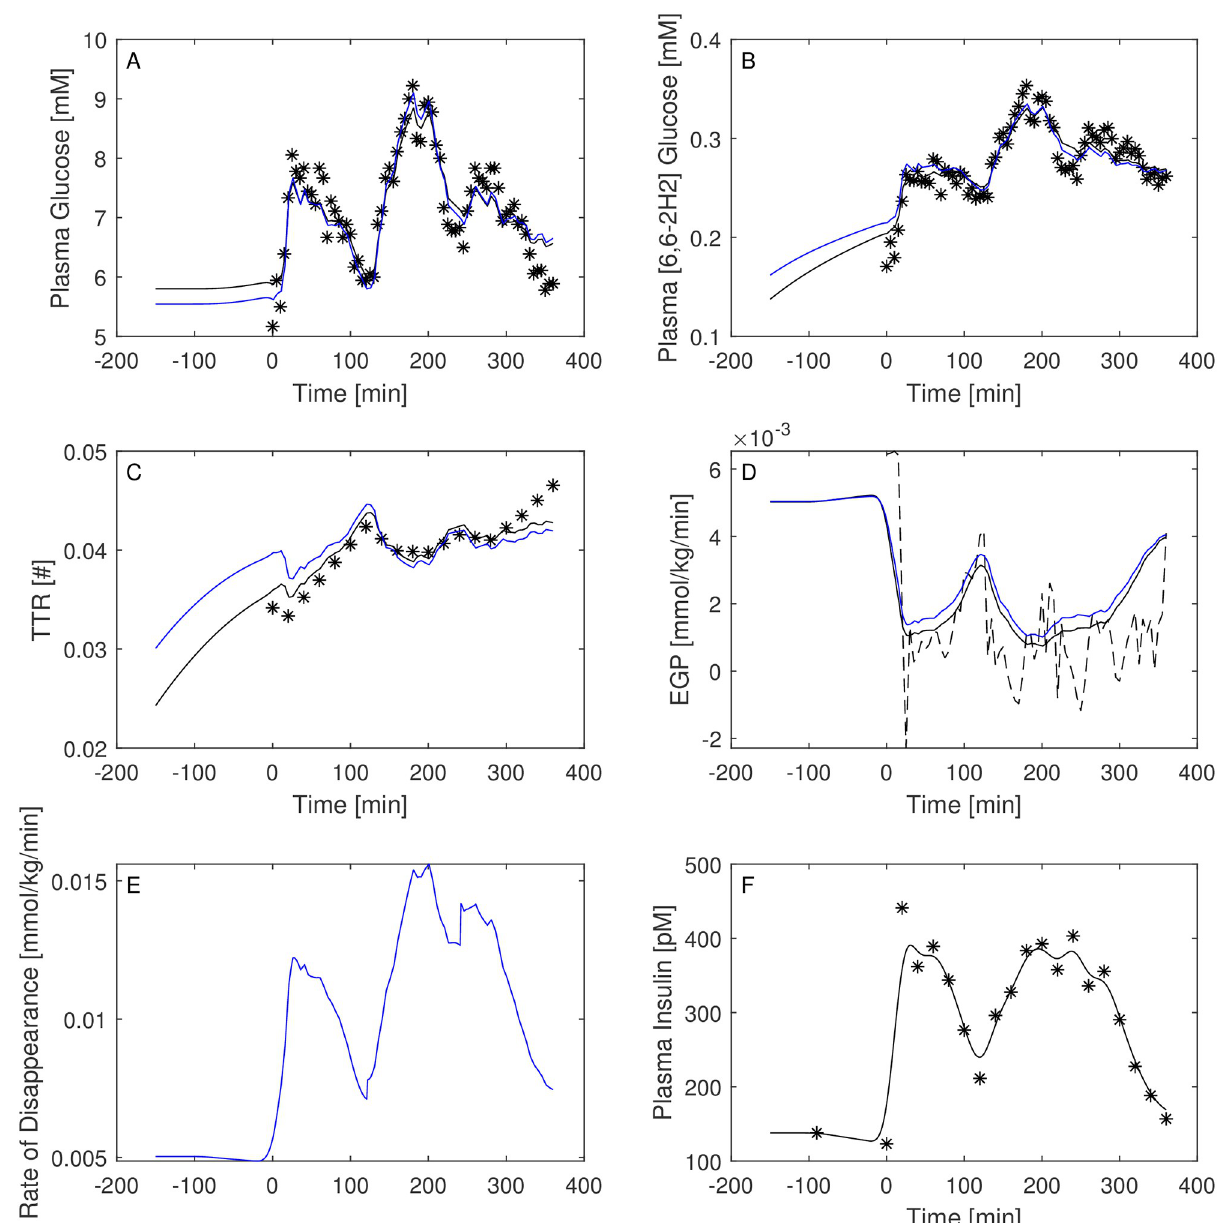
Fig 8. Predictions for Subject 6. Observed (asterisks) and predicted (line) variables over time (IGT subject). EGP: Endogenous Glucose Production; TTR: Tracer to Tracee ratio. Plasma glucose concentration (Panel A); Plasma [6, 6-2H2]glucose (Panel B); TTR (Panel C); EGP (Panel D), dashed line is the predicted EGP with the Steele model; Rate of disappearance (panel E); Plasma Insulin concentrations (Panel F). All the observed points refer to data measured on day 2. Plasma glucose concentrations (panel A) are derived from the glucose intra-venous infusion to match plasma glucose observations from the OGTTs of day 1. Black lines in panels A, B, C, D and E are model predictions from WLS estimation procedure; blue lines derive from the estimation approach which uses autocorrelated errors.